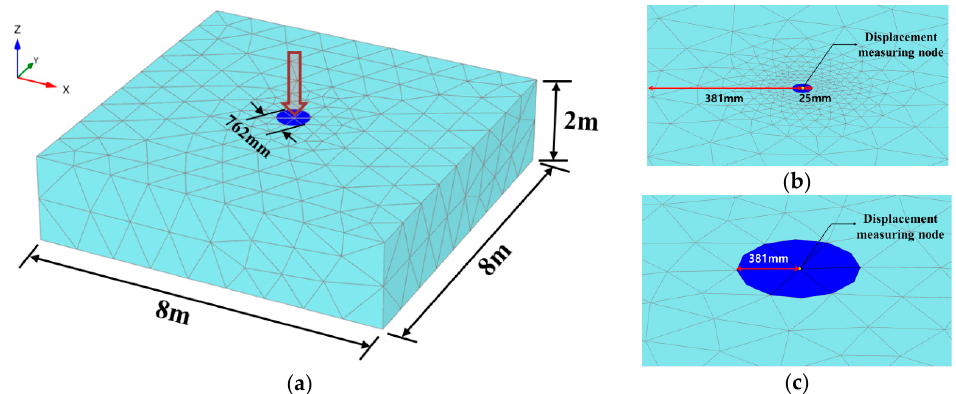
Figure 2. Numerical model using PLAXIS 3D: ( a ) Model of 762-mm loading plate; ( b ) Mesh in 50-mm loading plate model; ( c ) Mesh in 762-mm loading plate model.